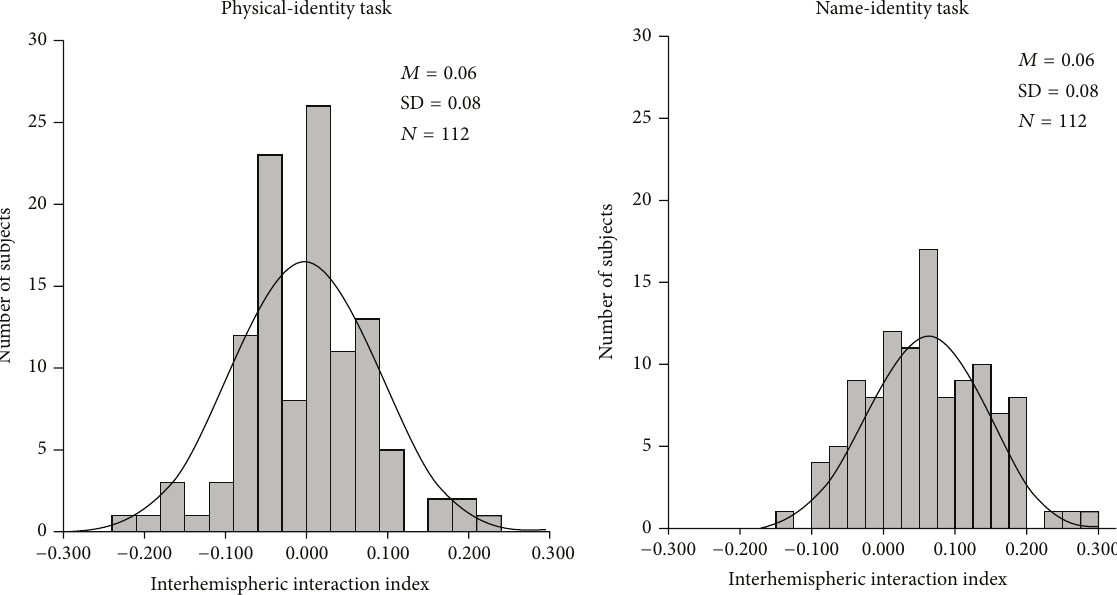
Figure 4: The distribution of interhemispheric interaction index scores for the physical- and the name-identity task. Interhemispheric